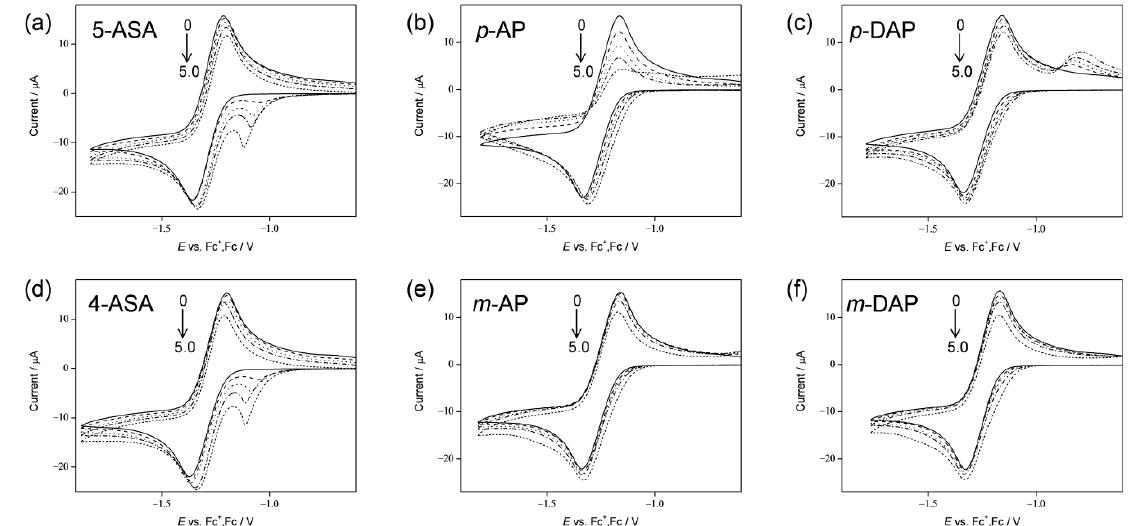
Figure 1. Structures of 5-ASA and related compounds considered in this study. ( a ) 5-amino-2-hydroxybenzoic acid (5-ASA), ( b ) 4-aminophenol ( p -AP), ( c ) 4-dimethylaminophenol ( p -DAP), ( d ) 4-amino-2-hydroxybenzoic acid (4-ASA), ( e ) 3-aminophenol ( m -AP), and ( f ) 3-dimethylaminophenol ( m -DAP).